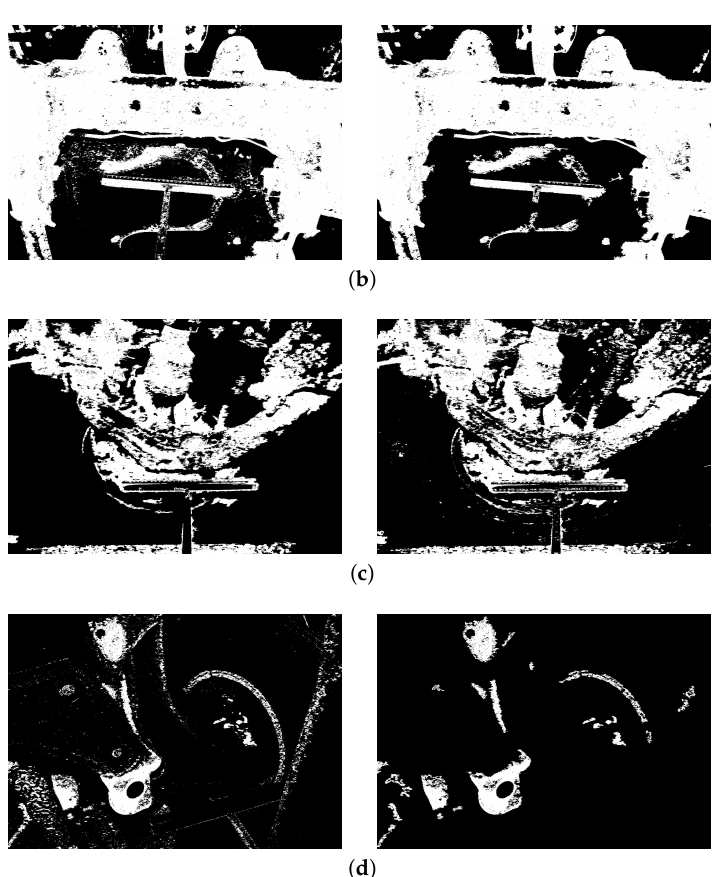
Figure 5. Extraction and quantification of the corroded area after thresholding ( left ) and filtering ( right ). ( a ) Surface Rust Percent = 22.78%; ( b ) Surface Rust Percent = 67.95%; ( c ) Surface Rust Percent = 40.17%; ( d ) Surface Rust Percent =